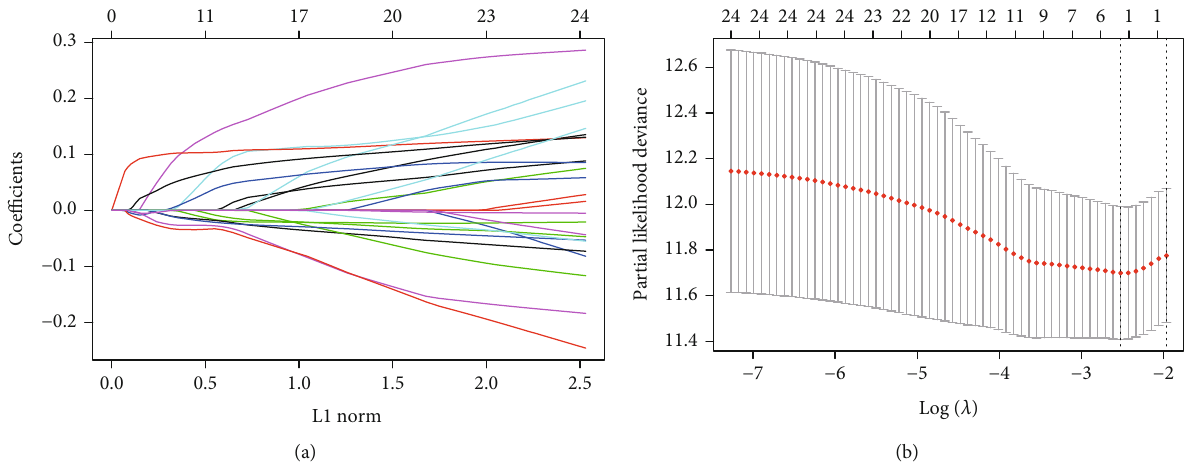
Figure 2: Prognostic gene screening was conducted through lasso Cox regression analyses. Positive and negative regression coe ffi cients, respectively, correspond to positive and negative correlations between numbers (a). The best parameter ( λ ) in the lasso analysis was then selected